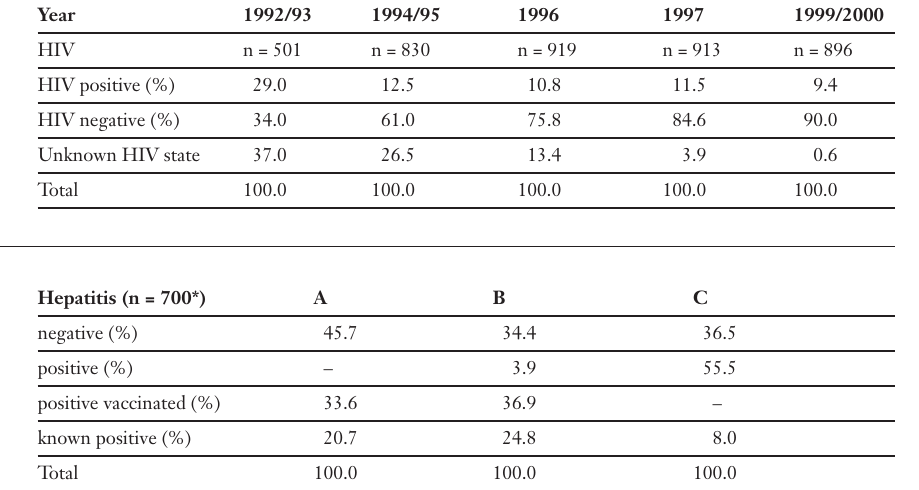
HIV prevalence between 1992 and 2000 in patients in MMT.